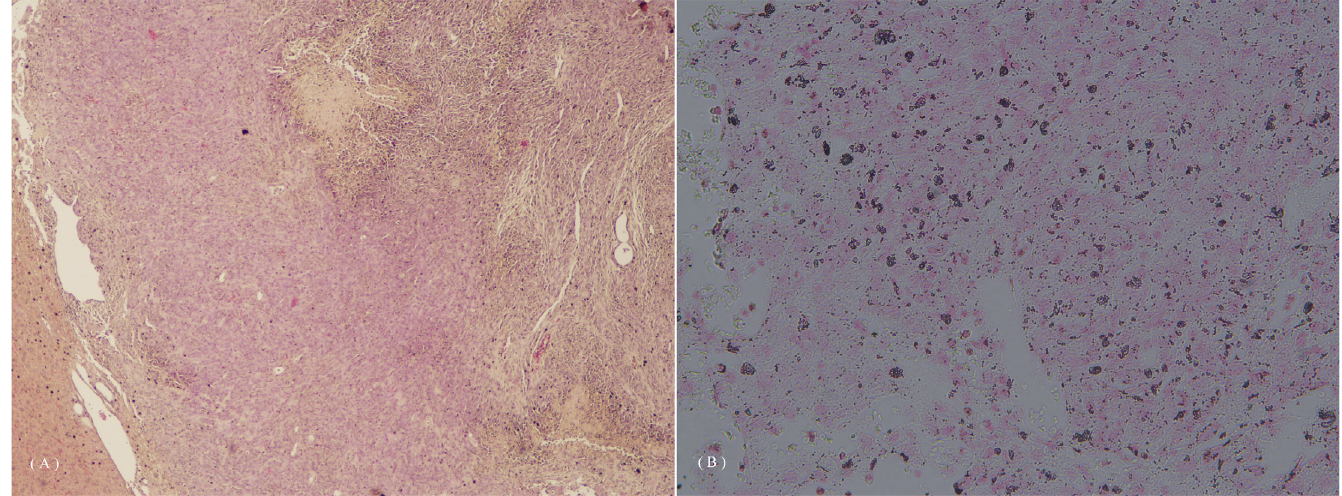
Fig 10. Liver pathology in the mouse after intravenous Gd-MnMEIO administration showed deposition of the contrast agent. (A) Hematoxylin and eosin staining, HE staining; (B) Prussian blue staining, PB